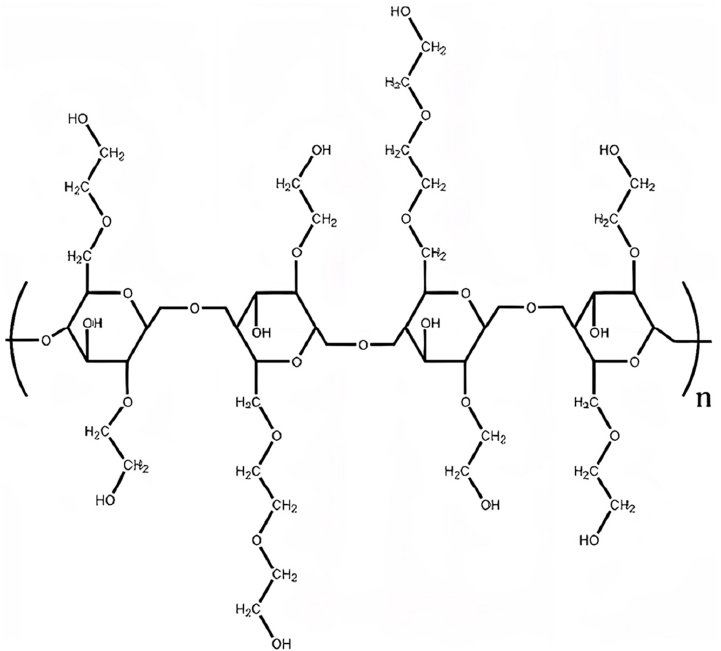
Figure 3. Idealized chemical structure of HEC with degree substitution 2.0 and molar substitution 2.5. Like most branched polysaccharides, HEC is capable of forming highly viscous solutions at low concentrations. During dispersion in water, the pendant hydroxyethyl and dihydroxyethyl groups attached to the cellulose core interact via hydrogen bonds with water molecules. Because of this, HEC molecules are intermolecularly intertwined in the aqueous phase, which in turn leads to an increase in viscosity and gelation. With a further increase in the concentration of HEC, an increase in viscosity and gelation occurs, in this case, water molecules form an ordered structure around the HEC molecule and thereby lead to a multiple increase in structural and rheological characteristics [38].